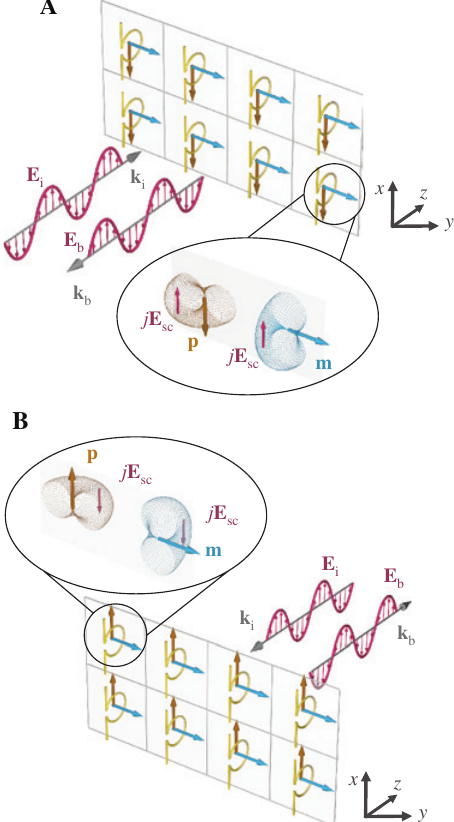
Figure 9: Illustration of asymmetric co-polarized reflection enabled by omega bianisotropic coupling in the metasurface. Illumina- tion is along (A) the + z and (B) - z direction. For clarity, only dipole moments generated due to bianisotropic coupling are shown: α = ⋅ ˆ p H and α = ⋅ ˆ . m E The insets depict the radiation patterns of em i me i the dipole moments. Only one half of each pattern is shown. Total backscattered (reflected) field from the metasurface is different for different